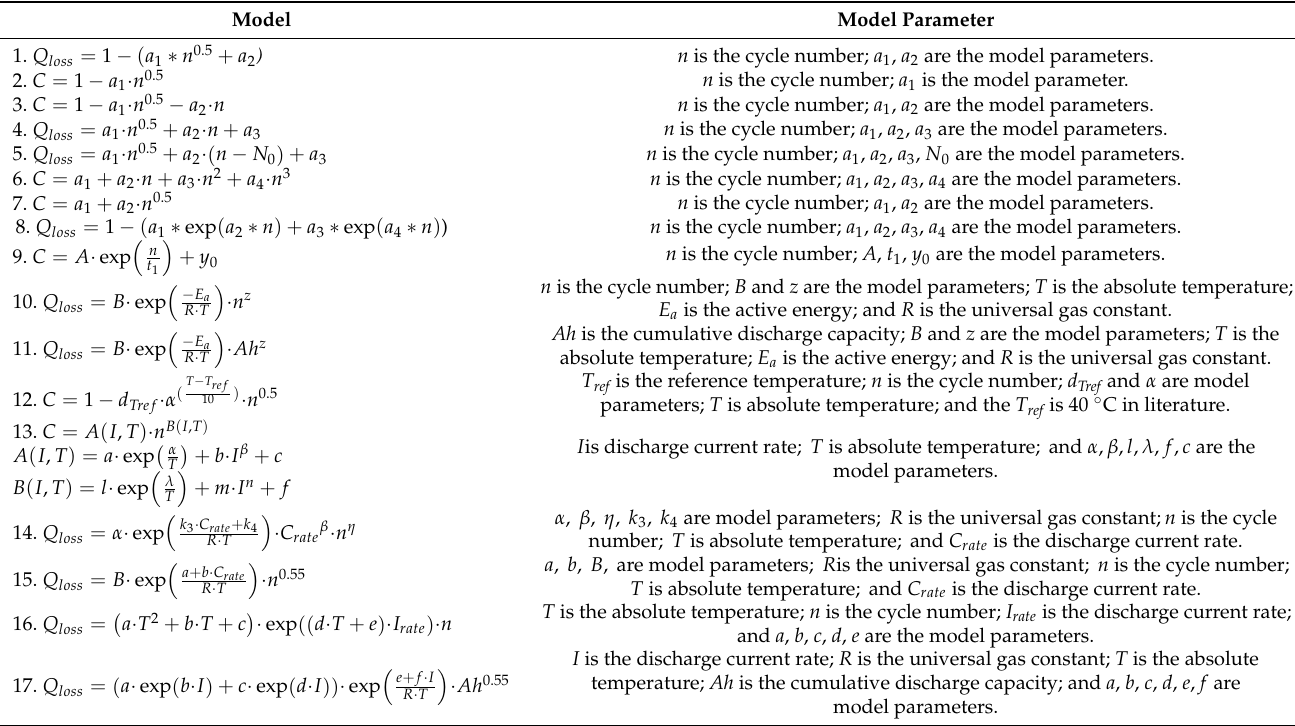
Table 5. The reported empirical models of battery cycle